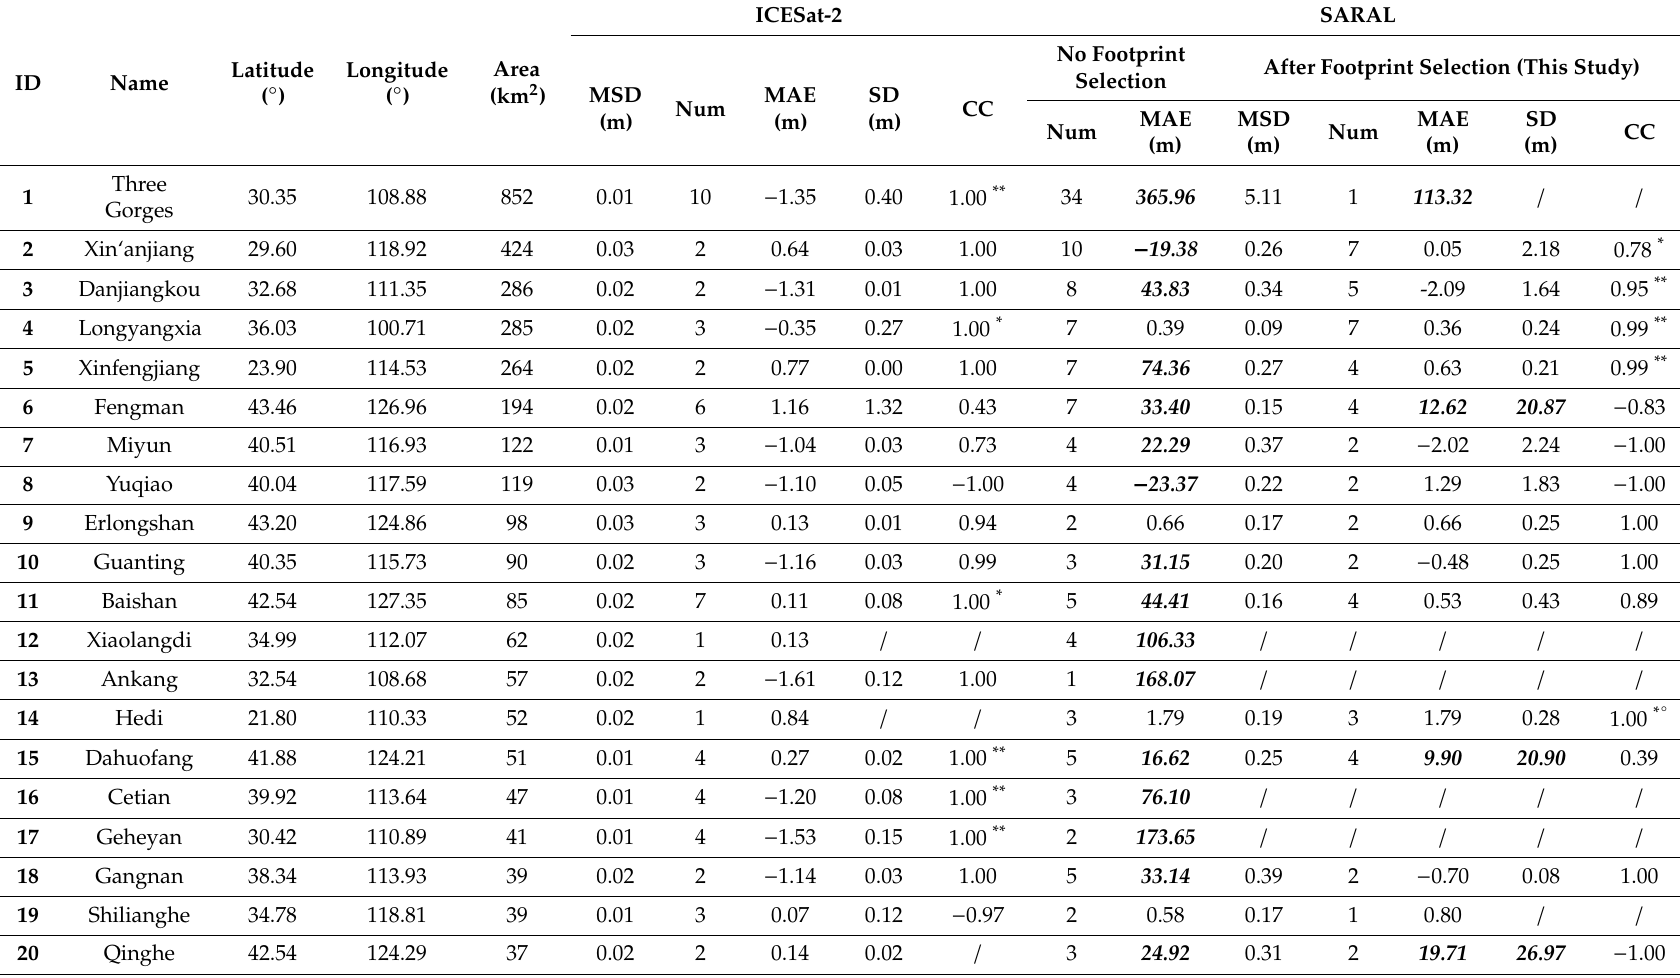
Table A1. Validation results of ICESat-2 and SARAL over 30